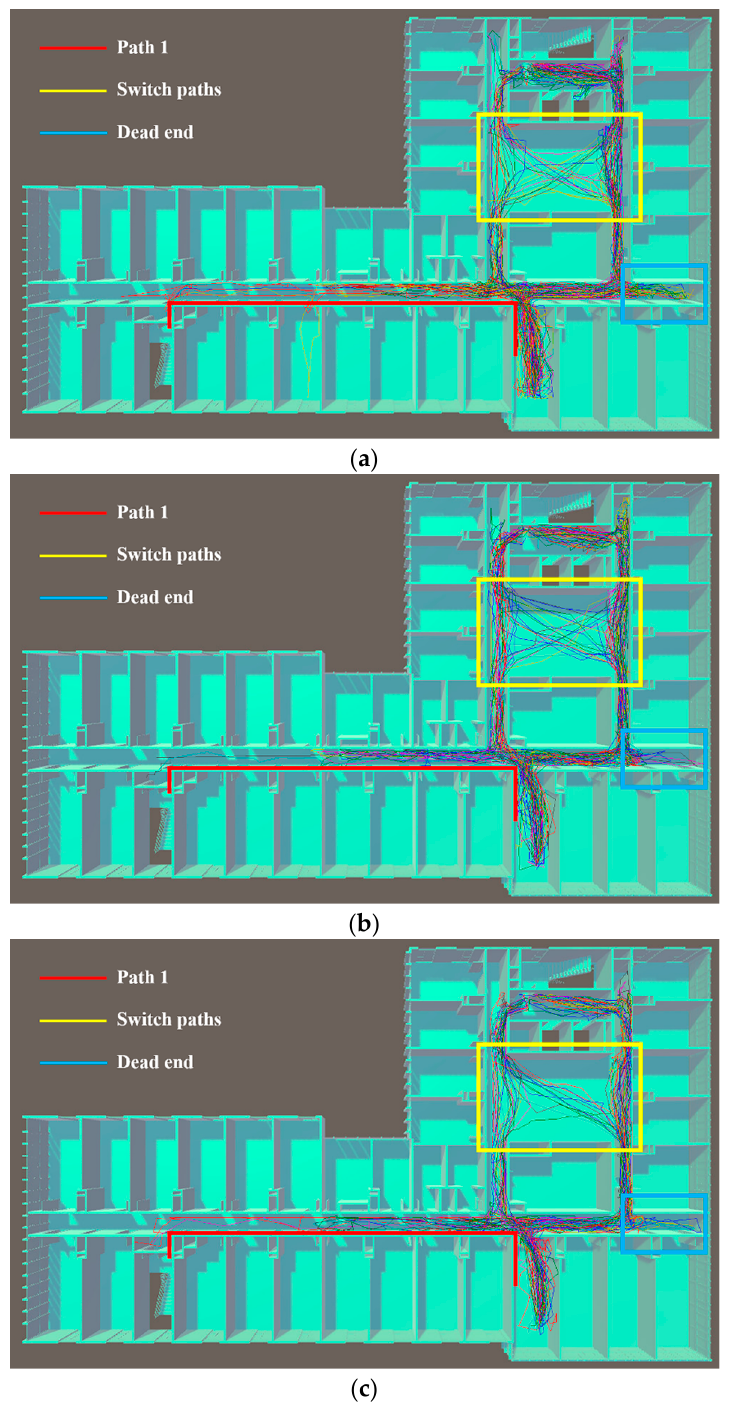
Figure 9. Evacuation paths of three drills. ( a ) First drill; ( b ) Second drill; ( c ) Third